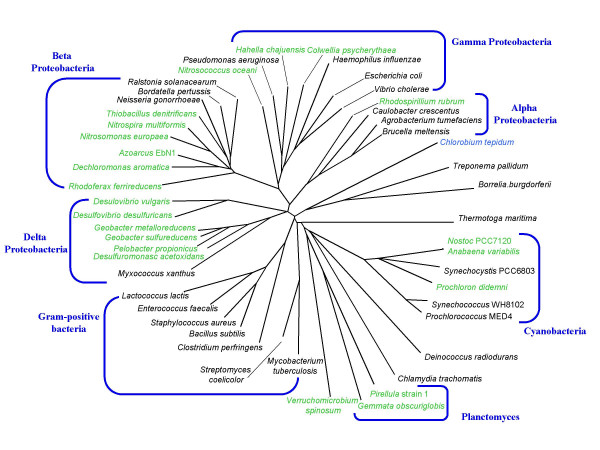
A phylogenetic tree based on 16S RNA of PEP-CTERM-containing and related organisms. Species with PEP-CTERM and an EpsH homolog are labeled in green. Chlorobium tepidum, which has only the PEP-CTERM domain, is shown in blue.